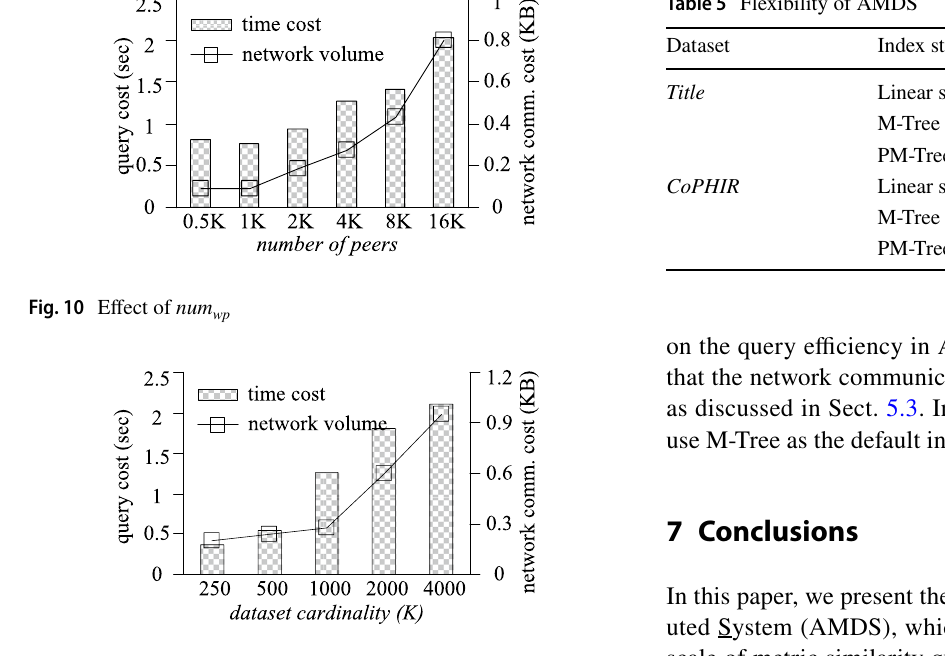
Fig. 11 Effect of